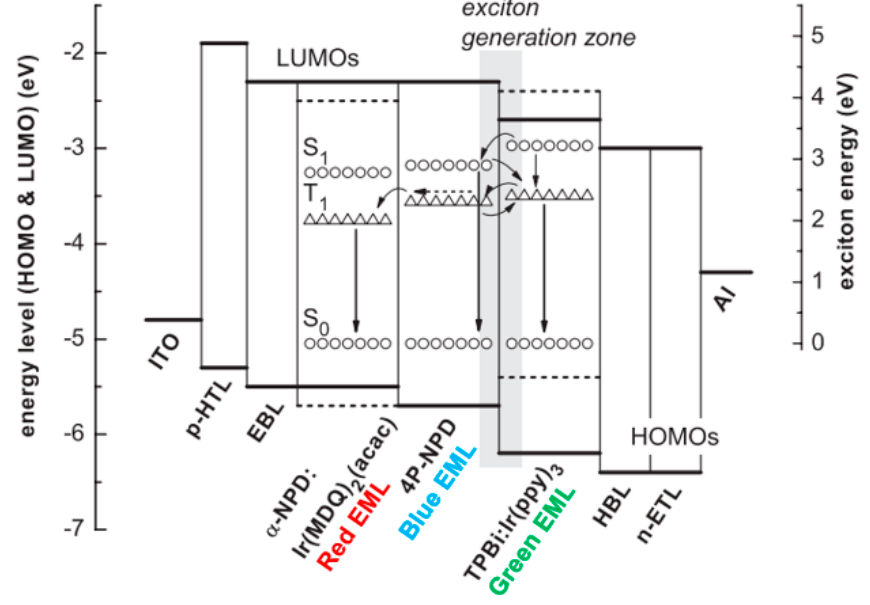
Figure 22. The WOLED structure, energy levels, and EL procedures. Reproduced from Reference [205].